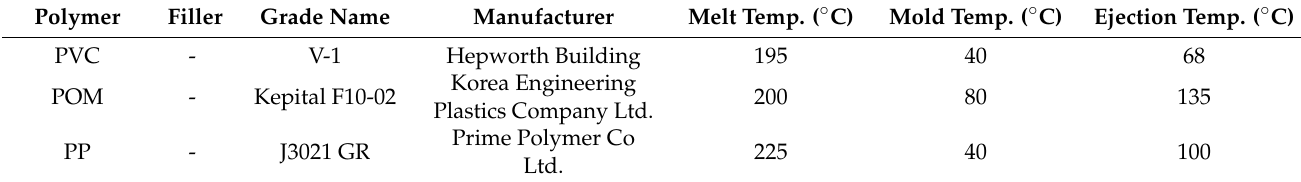
Table 4. Investigated polymers for the validation with recommended processing temperatures (according to Moldflow material data base of the software version 2016).